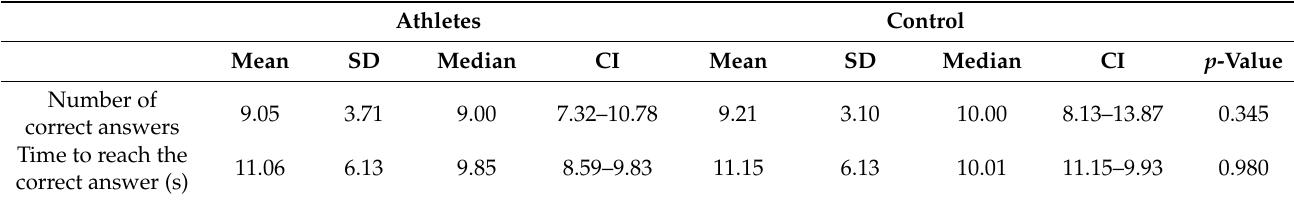
Table 2. “Same characters” test